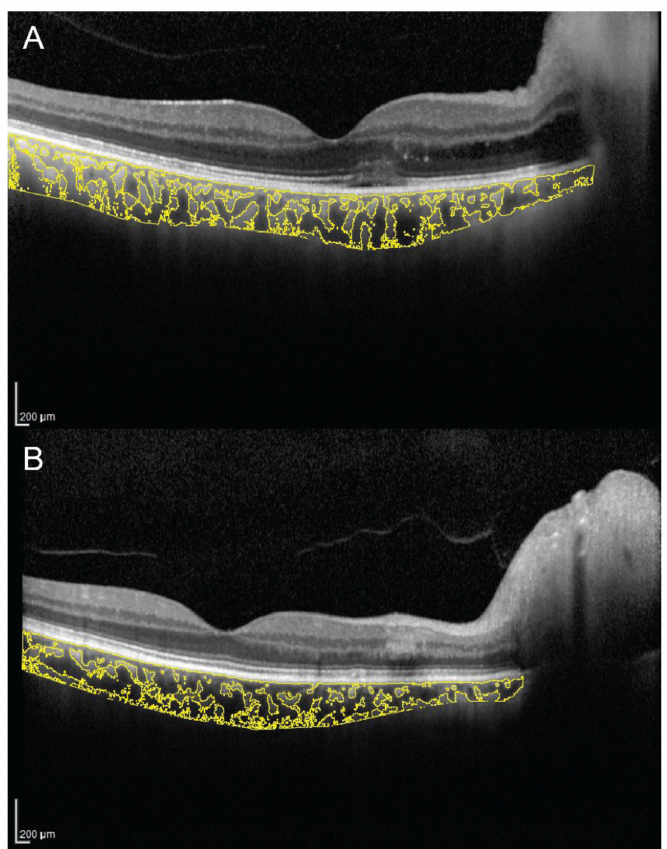
Figure 5. Choroidal vascularity index measurement in a patient with arteritic anterior ischemic optic neuropathy ( A ) and a patient with nonarteritic anterior ischemic optic neuropathy ( B ). ( A ) CVI was 65.1% in the patient with arteritic anterior ischemic optic neuropathy. ( B ) CVI was 68.3% in the patient with nonarteritic anterior ischemic optic